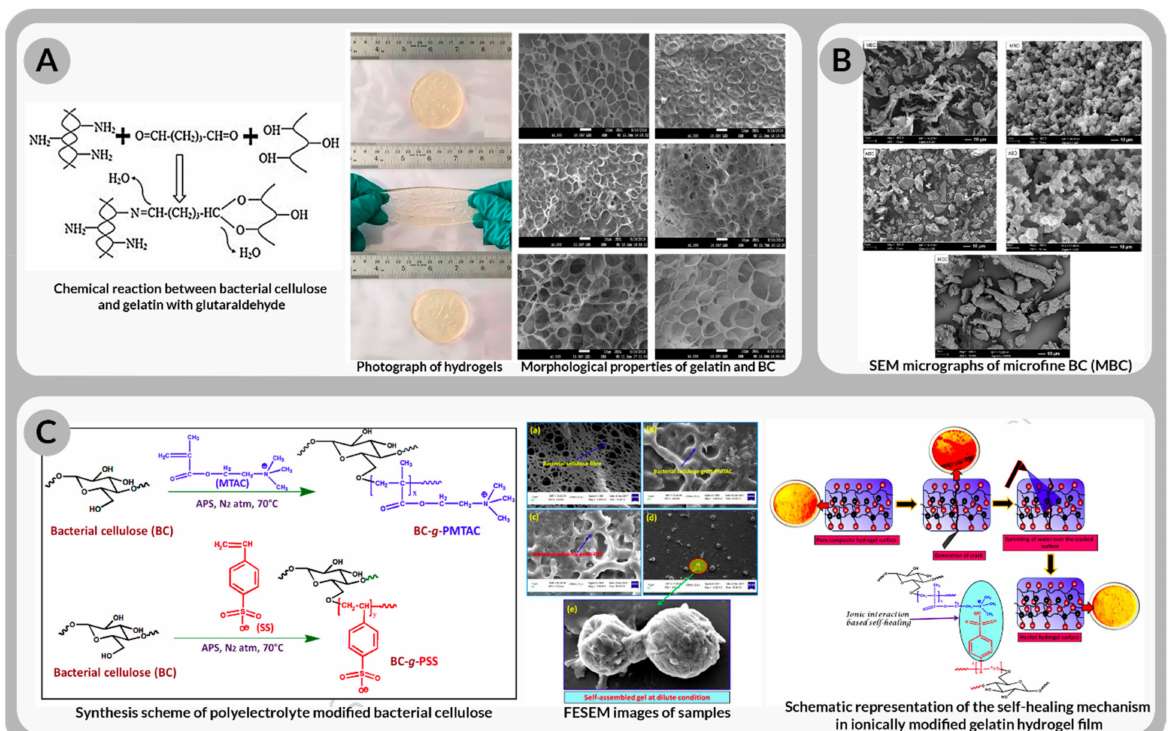
Figure 12. Images adapted from key studies using the ex situ “suspension/solution” (ExSSuSol) modification method. ( A ) BC/gelatin hydrogel composite formulation for drug delivery; adapted with permission from [176] ( B ) Purification, characterization and comparative studies of spray-dried BC microparticles; adapted with permission from [149] ( C ). Curcumin entrapped in gelatin/ionically modified BC-based self-healable hydrogel film adapted with permission from